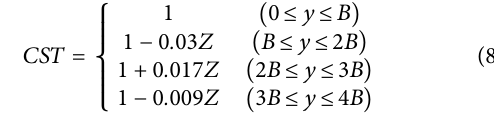
Variation of effective stress at the bottom of strata